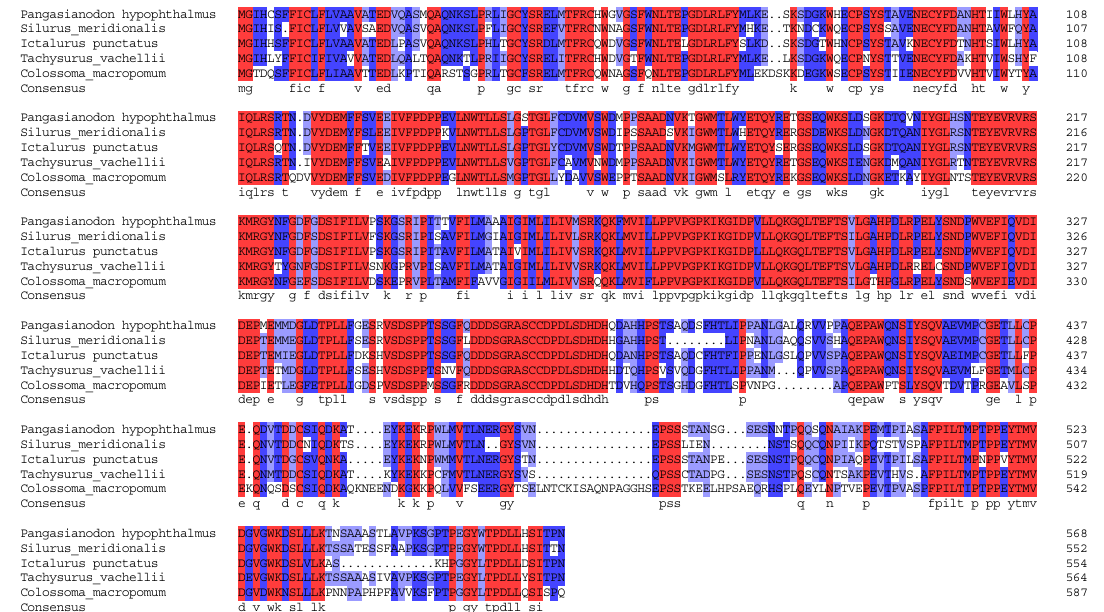
Figure 1. Multiple amino acid sequence alignment of GHR in Pangasianodon hypophthalmus with Ictalurus punctatus , Tachysurus vachellii , Silurus meridionalis , and Colossoma macropomum . The red indicates the same amino acid and the number on the right indicates the amino acid position of GHR in the different species. Different colors represent the degree of homology level. Red indicates 100% identity between species, dark blue indicates ≥ 75% identity, and light blue indicates ≥ 50% identity.